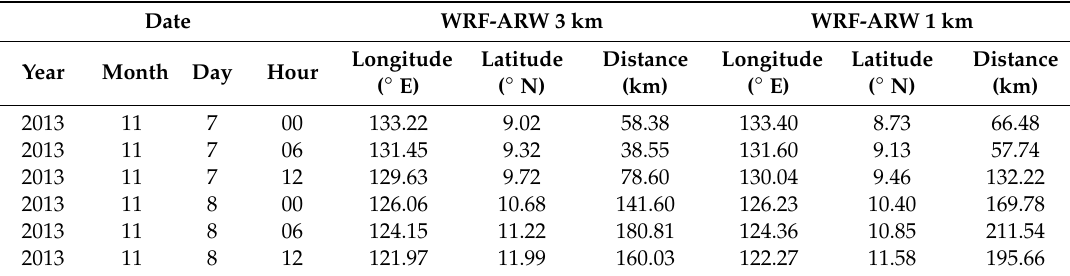
Figure 9. Comparison of storm tracks among JMA best-track (black line), weather research and forecasting-advanced research WRF (WRF-ARW) 3 km (blue line), and WRF-ARW 1 km (red line). The storm centers are illustrated every 6 h. The temporal resolution of storm center’s location: JMA best-track—6 h; WRF-ARW 3 km and 1 km—1 h. Table 3. The storm centers of WRF-ARW 3 km and WRF-ARW 1 km and their distances apart from those of the JMA best-track. The distance between the predicted storm center of WRF-ARW and that of the JMA best-track is calculated by the great-circle distance formula.